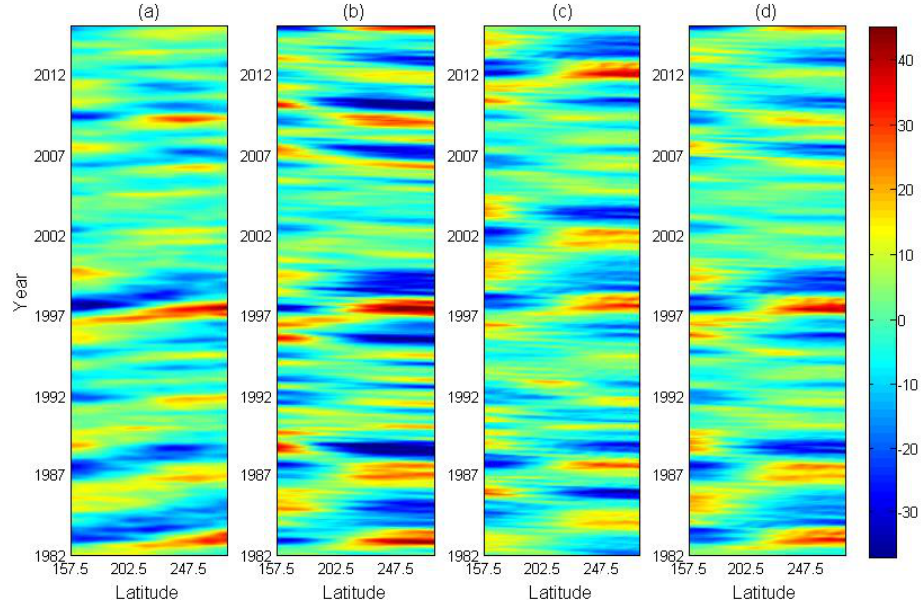
Figure 6. Time–longitude diagrams of ULD anomalies over the equatorial region: ( a ) SODA reanalysis and simulations from ( b ) Ori-Assim, ( c ) EAKF-Assim, and ( d ) EAKF_F-Assim schemes.